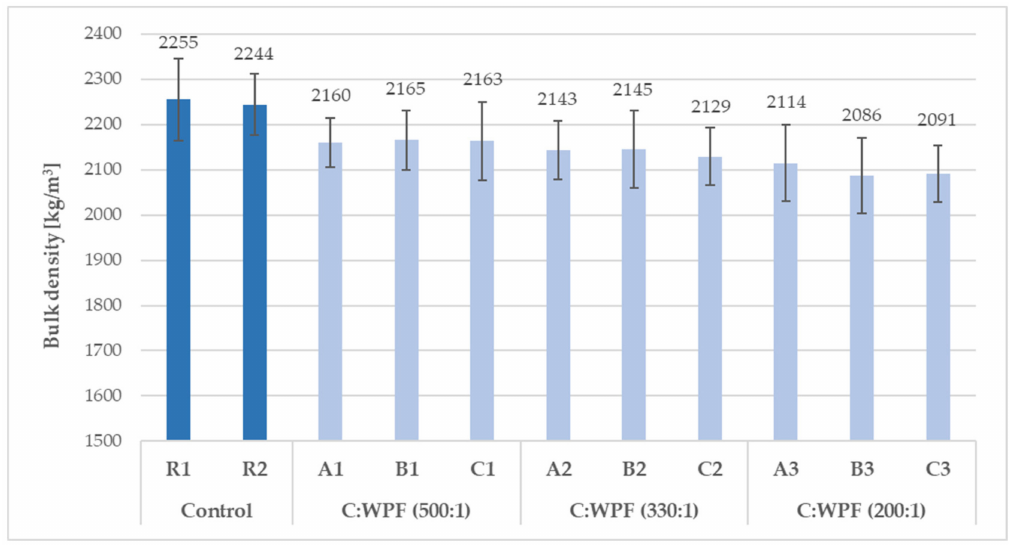
Figure 7. Development of bulk density with C/WPF ratios in fiber-cement mortars (set I) after 28 days of hardening.